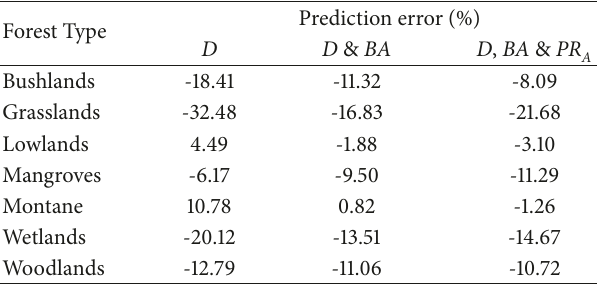
Table 7: Prediction error of the fitted base and generalized regional models to the studied forest